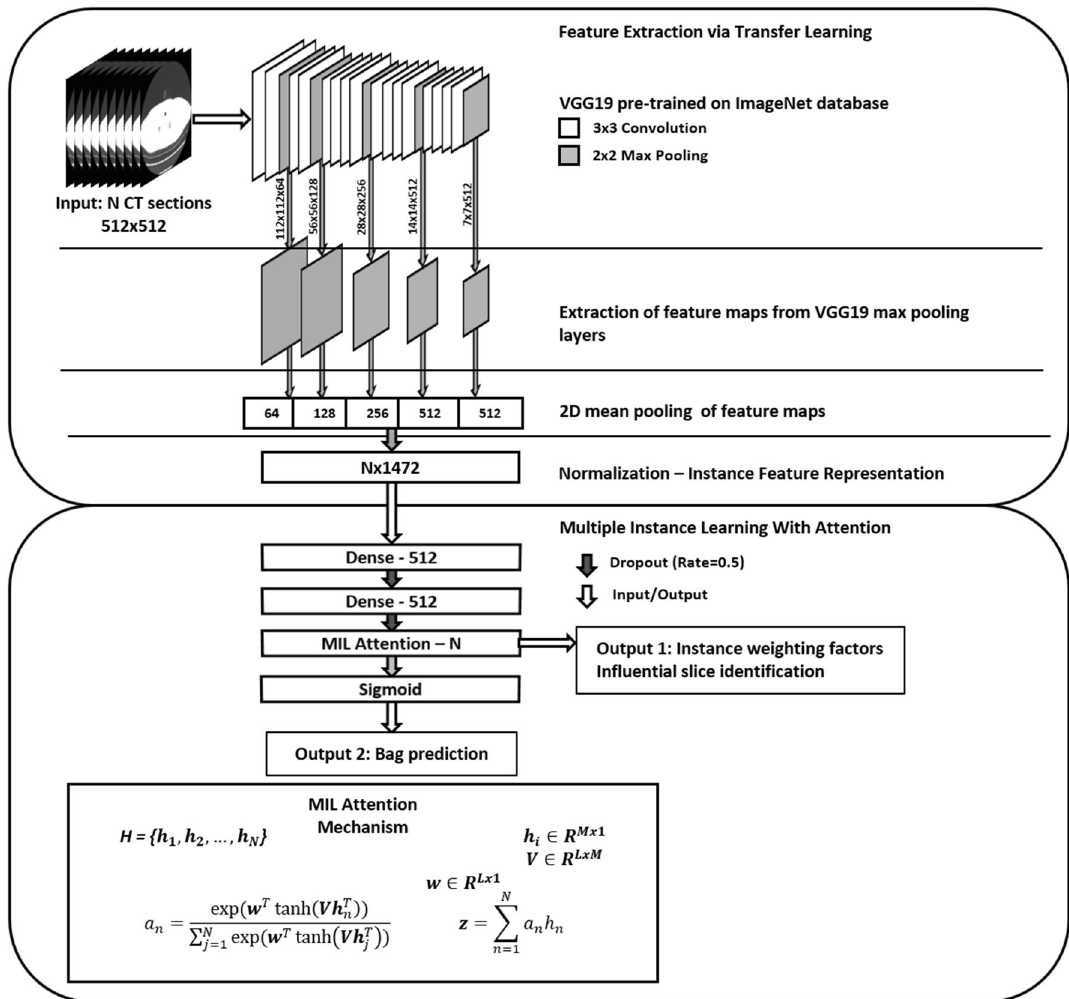
Figure 1. Model workflow of the Transfer AMIL approach. This includes feature extraction of CT images through an ImageNet pre-trained model based on methods developed by Antropova et al. followed by attention- based MIL pooling based on methods developed by Ilse et al. Two outputs are generated for each LDCT scan input, the attention weights which identify influential slices for the classification task and the scan prediction for the presence of emphysema.